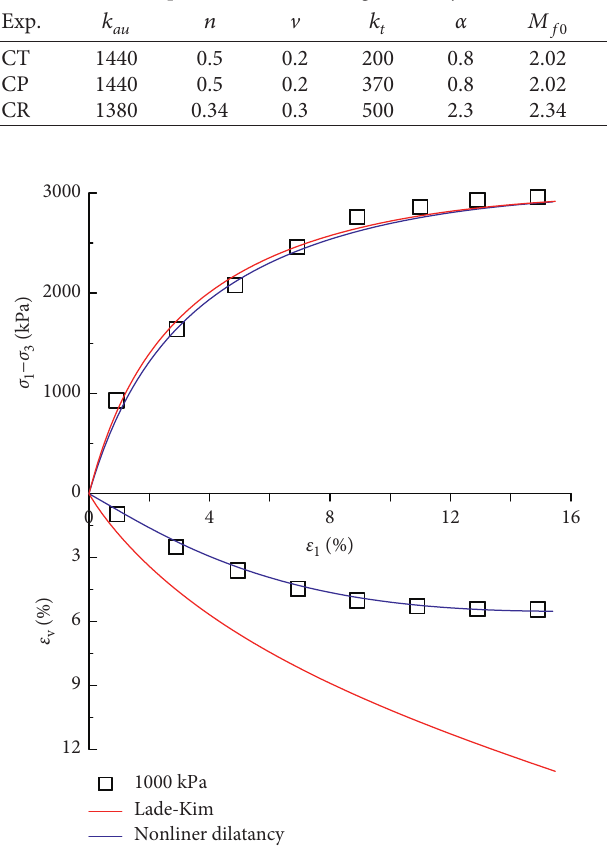
Figure 15: Model prediction results for CT experiments.